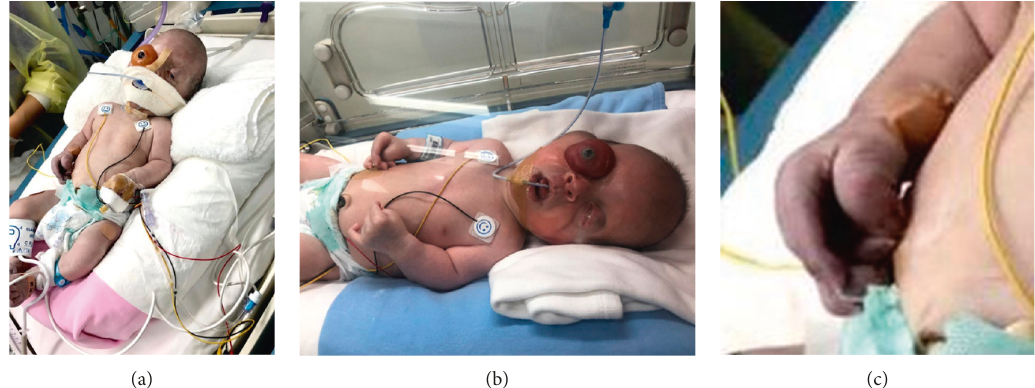
Figure 2: (a) Oropharyngeal airway to correct airway obstruction, long bones with proximal rhizomelia, and severe right eye proptosis. (b) Mid-facial hypoplasia, brachycephaly, cloverleaf skull, and bilateral ocular proptosis more severe on the right with absent eyelids (c) Broad thumb with medial deviation of the